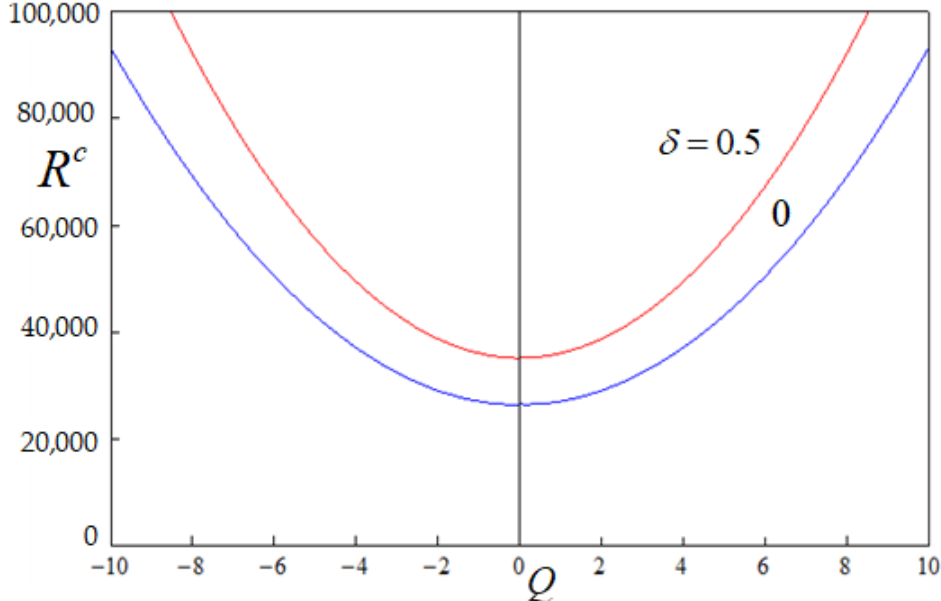
Figure 7. Plot of R c versus Q for two values of δ for case (i) of gravity variation with Le = 0.5, Rs = 10, Da = 100, ξ = 0.5 and η = 0.5.